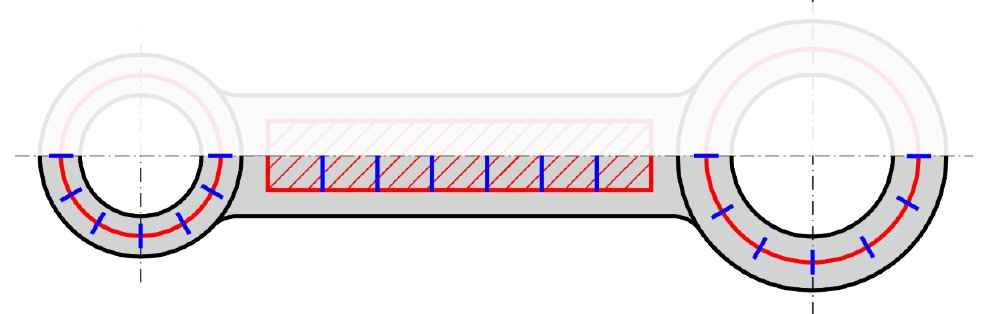
Figure 10. Defect subdomains with regard to the position of a through-hole defect in a connecting rod taking advantage of part symmetry (red: defect domains; blue: borders of subdomains).